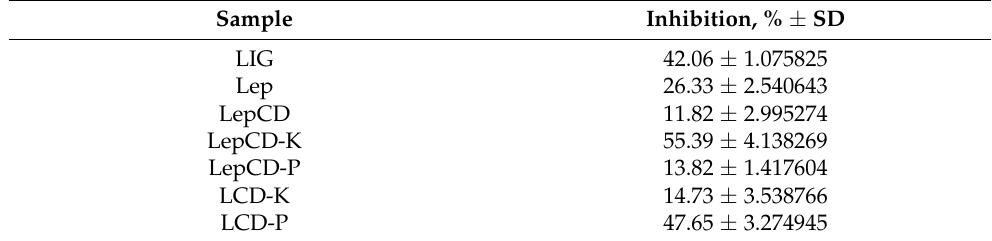
Table 5. Antioxidant activity of biomaterials.